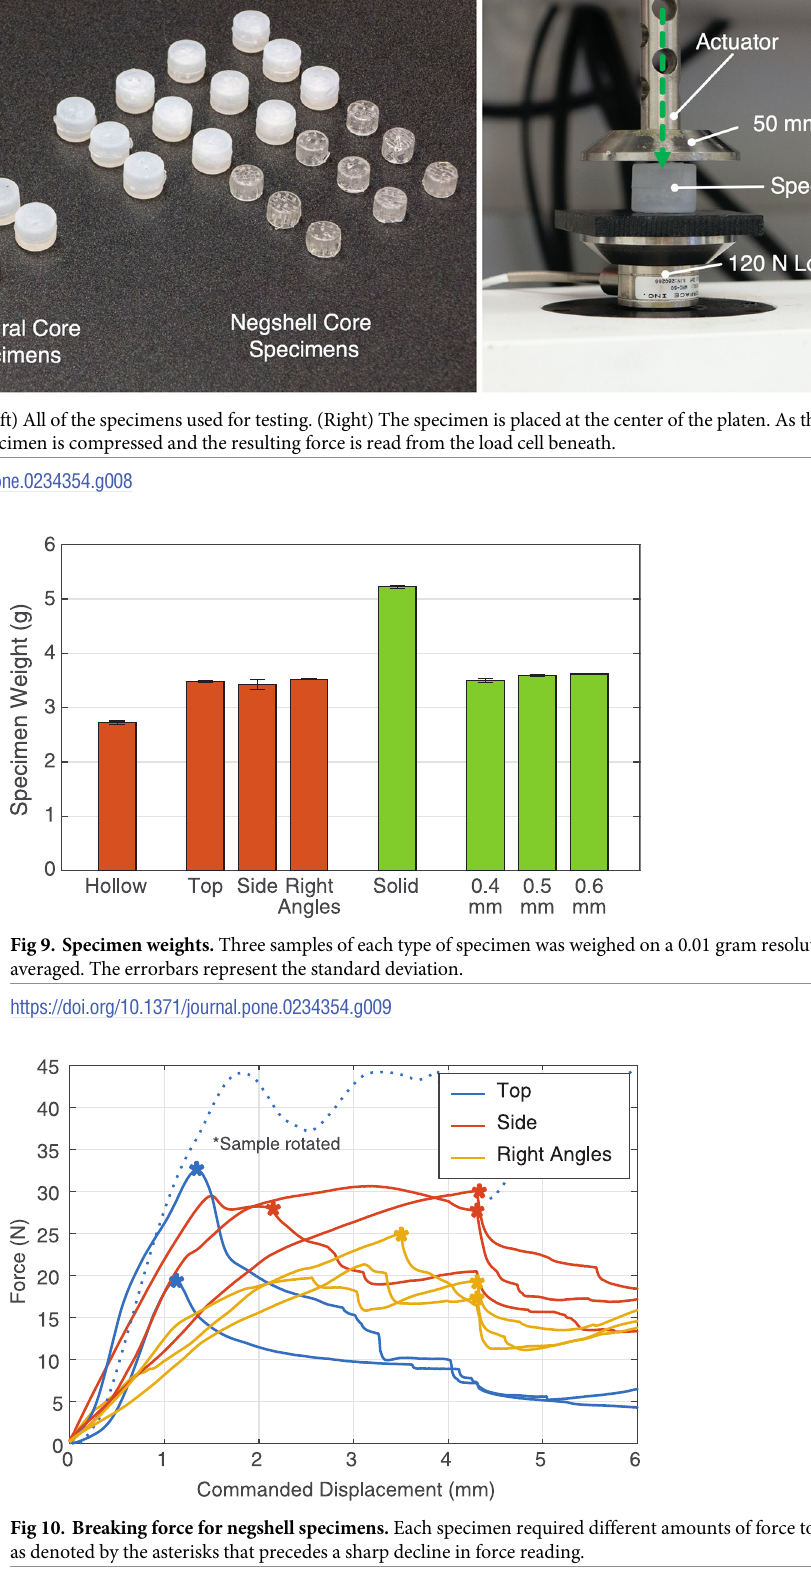
PLOS ONE | https://doi.org/10.1371/journal.pone.0234354 June 12,